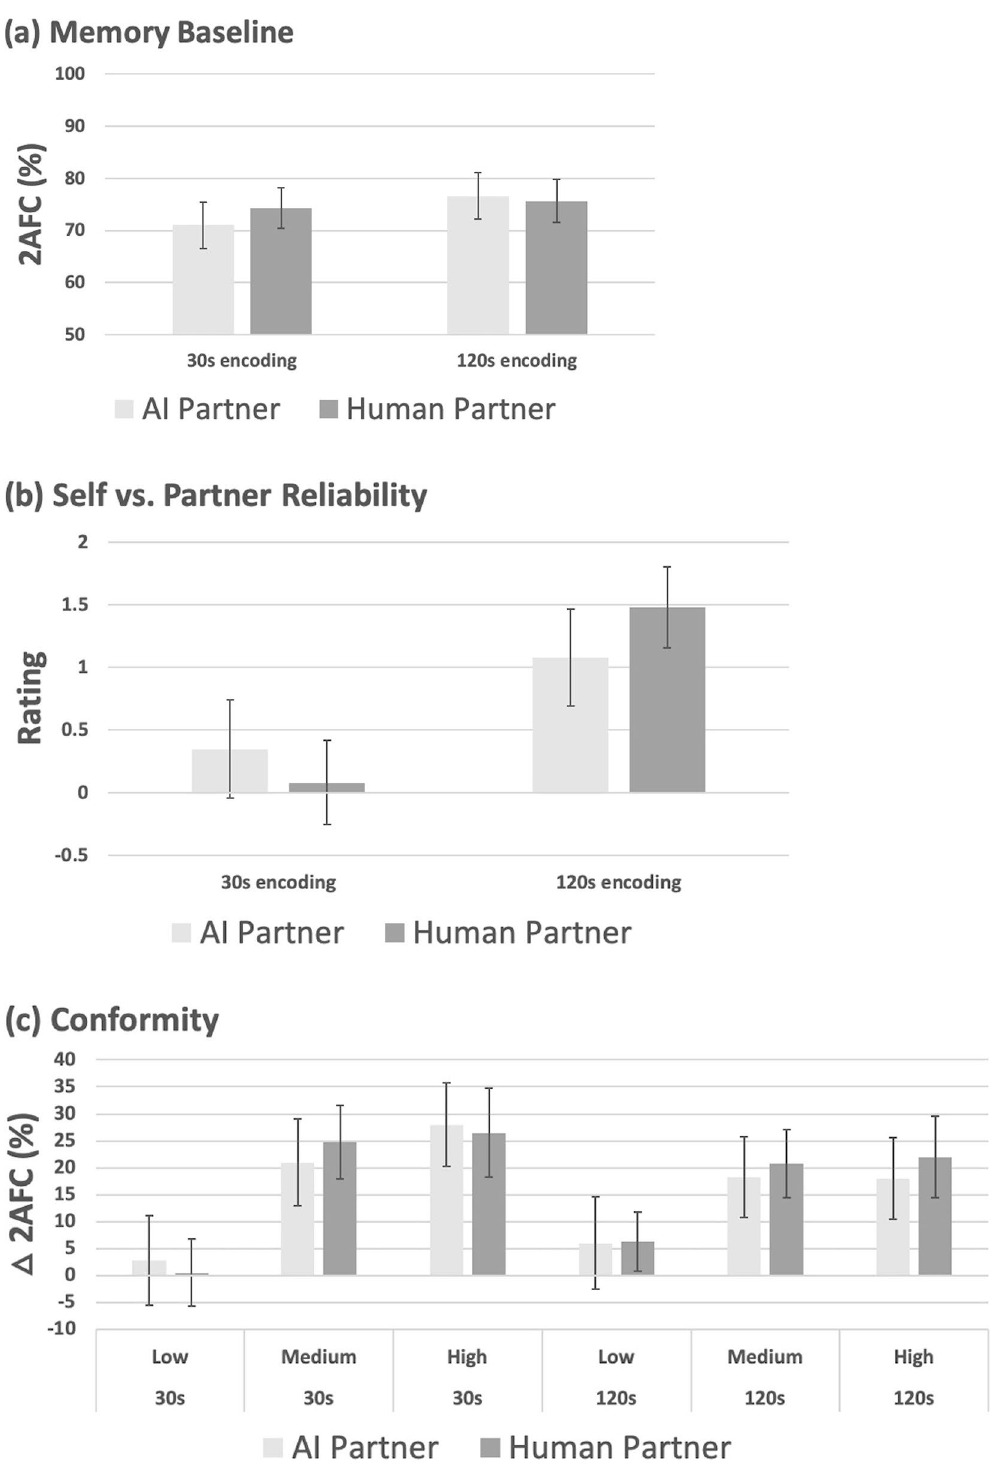
Figure 2. Data for Experiment 2 (Decision-likelihood effects). ( a ) Mean percentage baseline 2AFC performance (± 95% CI) following 30 s vs. 120 s viewing time at encoding, for the AI (light-grey) vs. human (dark-grey) groups. ( b ) Relative reliability ratings (± 95% CI) for participants own memory vs. AI or human partner following 30 s vs. 120 s viewing time at encoding. ( c ) Change in mean 2AFC performance ( △ 2AFC, ± 95% CI) induced by conformity to accurate minus errant high, medium and low likelihood decisions from AI vs. human partner about the content of images viewed for 30 s vs. 120 s at